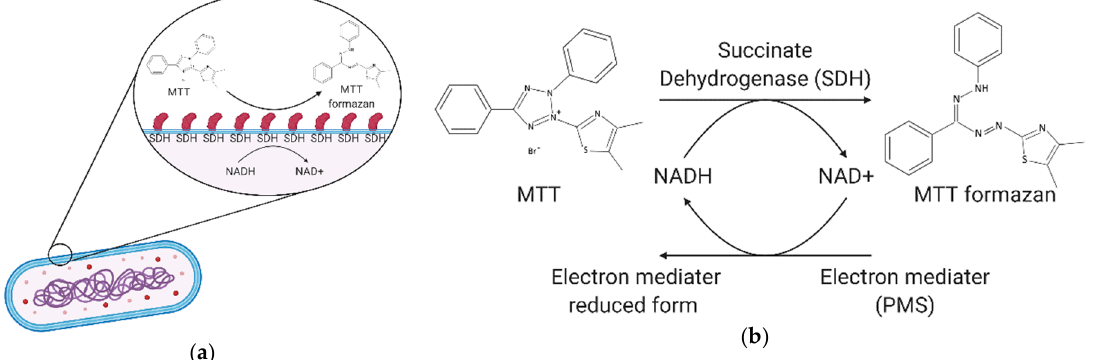
Figure 3. Mechanism of the bacterial reagent assay: ( a ) schematic diagram of the bacteria reagent assay and ( b ) MTT-PMS mechanism of our bacterial analytical device. Created with BioRender.com.